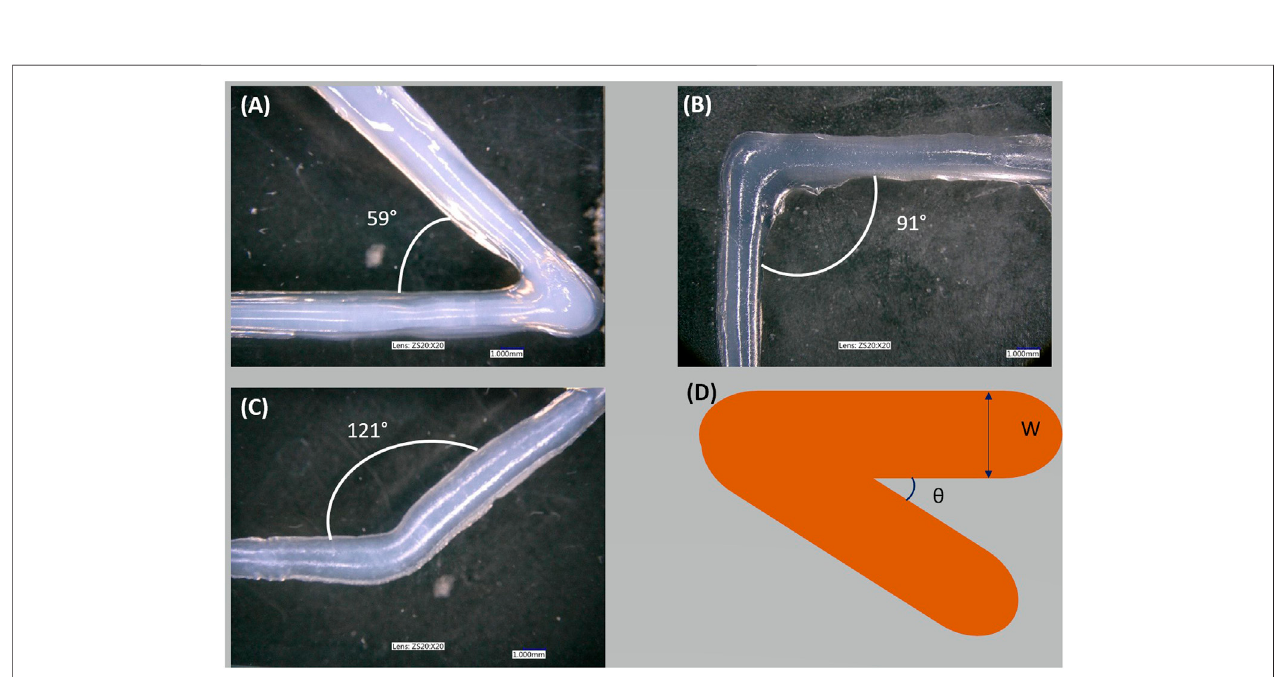
FIGURE 5 | Sharp corner printing: (A) shape of acute angle printing, (B) shape of right angle printing, (C) shape of obtuse angle printing, and (D) schema of the overlap.